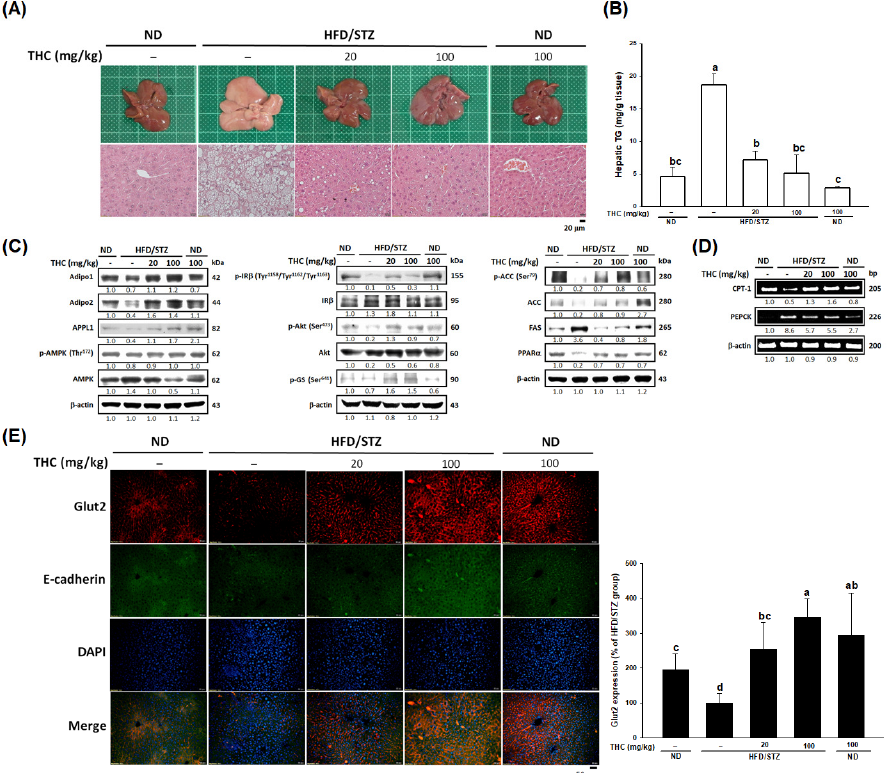
Figure 4. Amelioration of hepatic steatosis and by THC in HFD/STZ treated mice. ( A ) Macroscopic appearance (upper) and H&E staining (lower) of liver tissue. ( B ) Serum level of hepatic TG content was measured in each group ( n = 6). ( C ) AdipoR-APPL1 signaling, insulin signaling, lipogenesis and PPAR α protein level in the liver was detected by Western blot analysis. ( D ) Hepatic mRNA levels of CPT-1 and PEPCK was analyzed by RT-PCR. The data of Western blot and PCR shown are representative of three independent experiments with similar results. ( E ) Immunofluorescence staining with hepatic Glut2 (red), E-cadherin (green), and DAPI (blue). Quantitative data of immunostaining was performed by ImageJ ( n = 5). Data are presented as mean ± SEM ( n = 5–6). Statistical differences ( p < 0.05) between groups were evaluated by one-way ANOVA with Tukey’s post-hoc test and were labeled as different letters (a, b, and c).